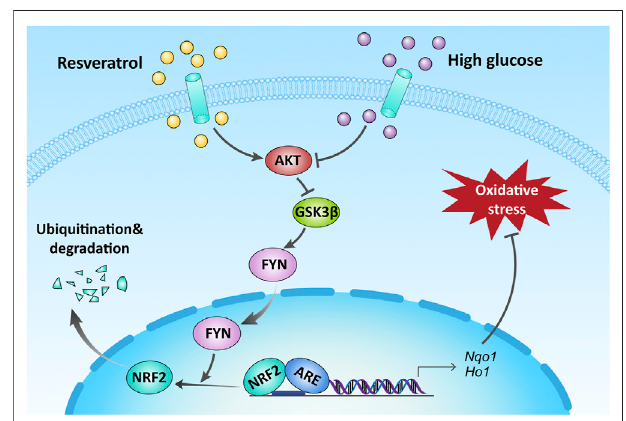
FIGURE 7 | Schematic illustration of the protection of RES against HG-induced osteoblast dysfunction via AKT/GSK3 β /FYN-mediated NRF2 activation. HG impaired the function of osteoblasts via oxidative stress. Upregulation of NRF2 by RES attenuated oxidative stress through promoting phosphorylation of AKT and GSK3 β and inhibiting FYN under a diabetic